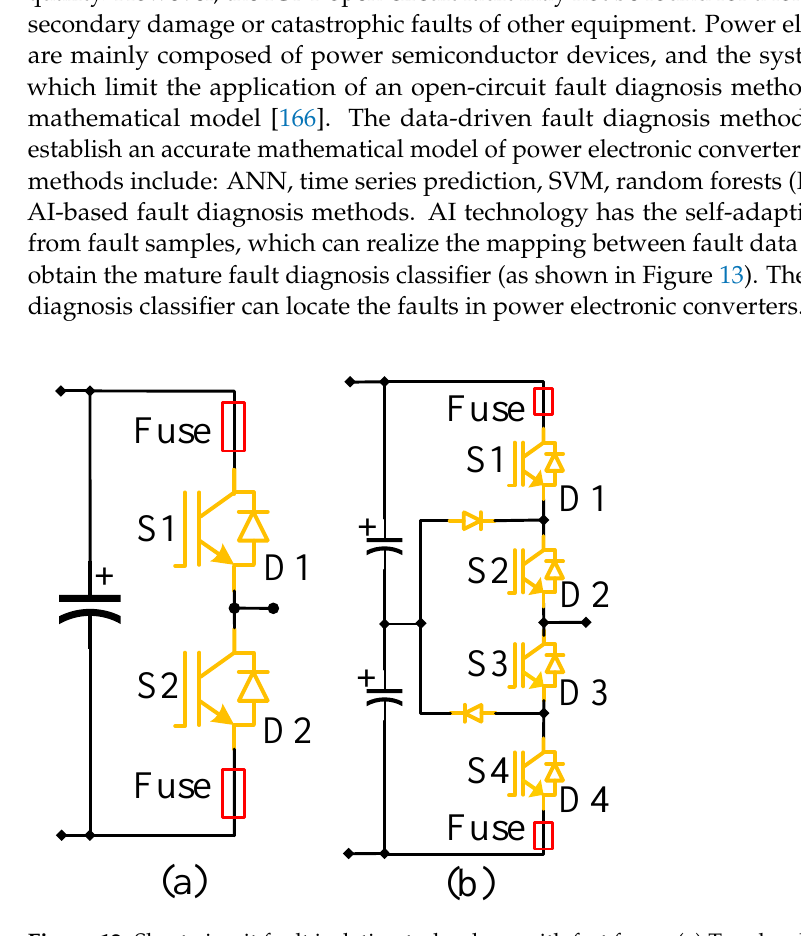
Figure 12. Short-circuit fault isolation technology with fast fuses: ( a ) Two-level; ( b )